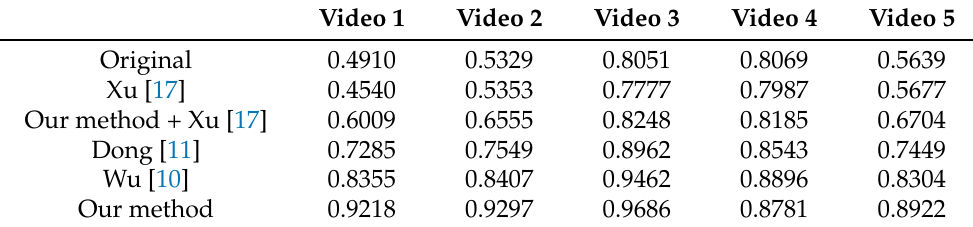
Table 2. SSIM Comparison of different methods for only background shaking videos.